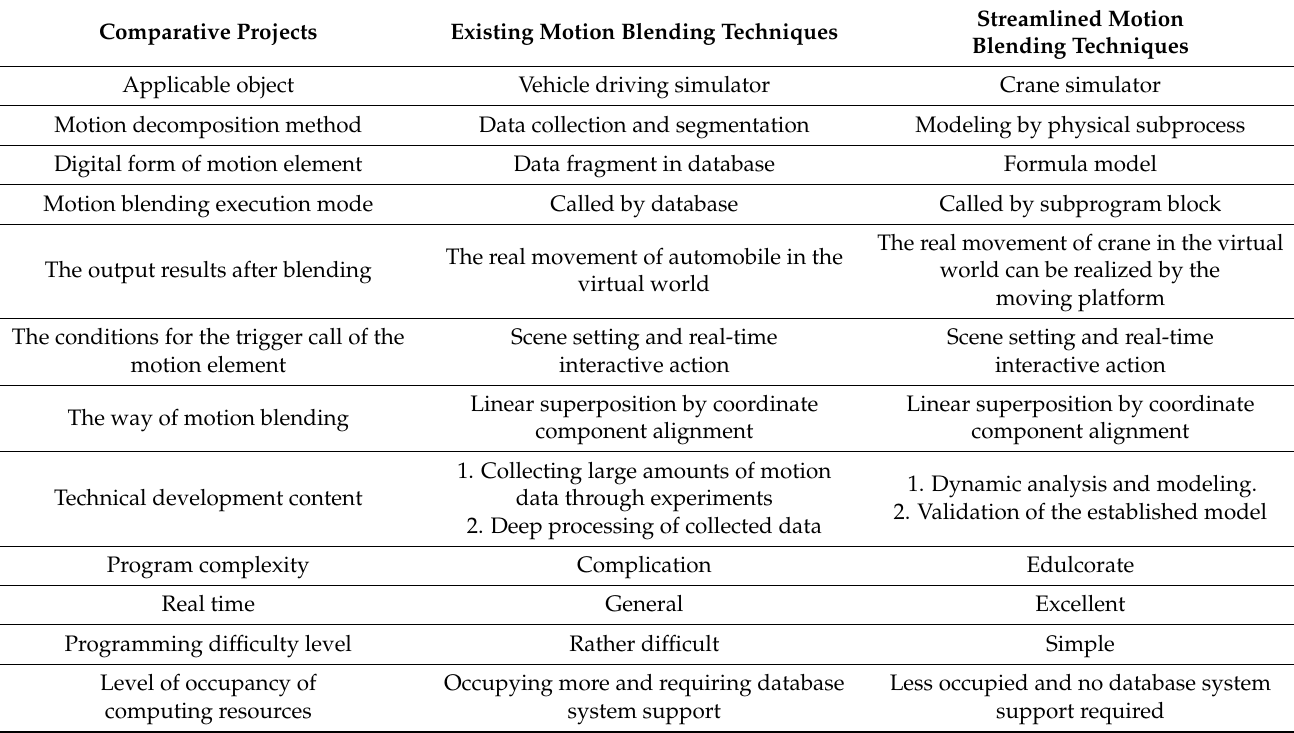
Table 2. Comparison of existing motion blending techniques and streamlined motion blending techniques in motion